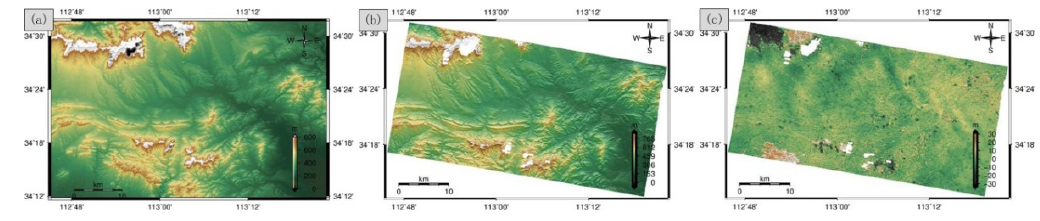
Figure 5. DEM products of Songshan region. (a) is the SRTM DEM map; (b) is the DEM generated by this paper; (c) is the elevation difference map of SRTM DEM and DEM generated by this paper.